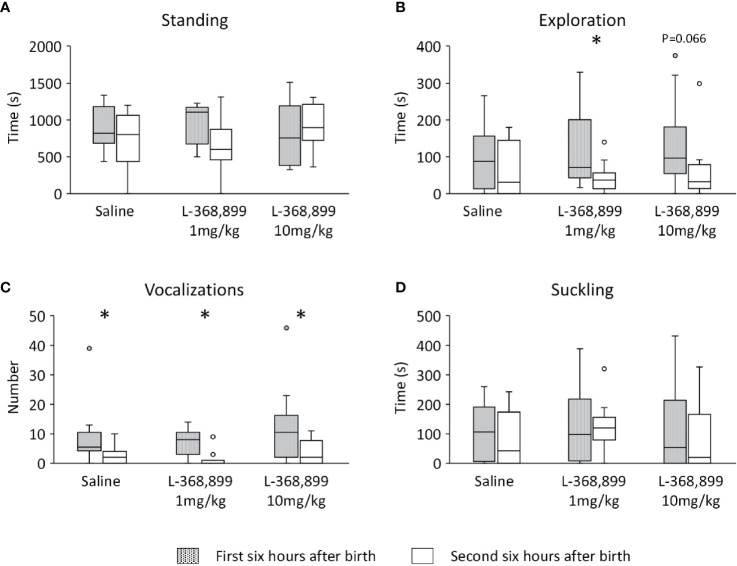
Lambs neonatal activities during the first 12 h after birth: (A) standing, (B) exploring the mother’s body (nosing, nuzzling), (C) number of vocalizations, and (D) suckling. Activities are represented in the first and second 6-h period of observation. At birth, lambs had unlimited access to the mother’s udder and received either saline (n=10) or L3688-899 at 1 mg (n=11) or 10 mg/kg (n=11) via orogastric tubing. Treatments were administered at birth, and then 2 and 4 h later. Data are expressed as medians and 1st and 3rd quartile. Paired box-plots associated with a star (*) are significantly different (p<0.05).